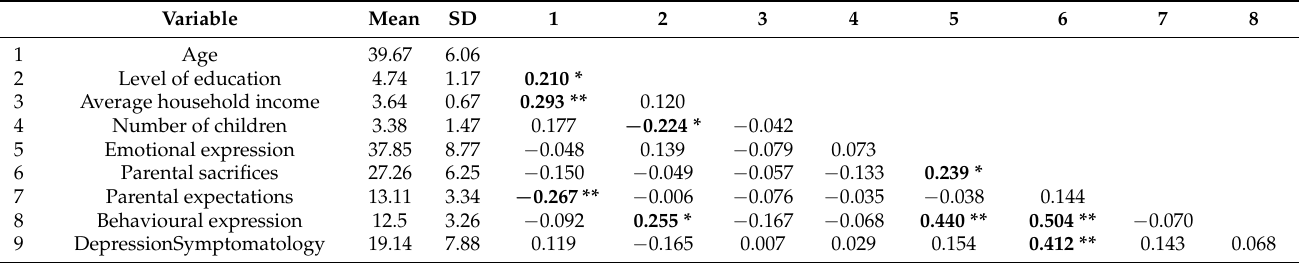
Table 2. Correlation coefficient of sociodemographic information, parental stress, and depressive